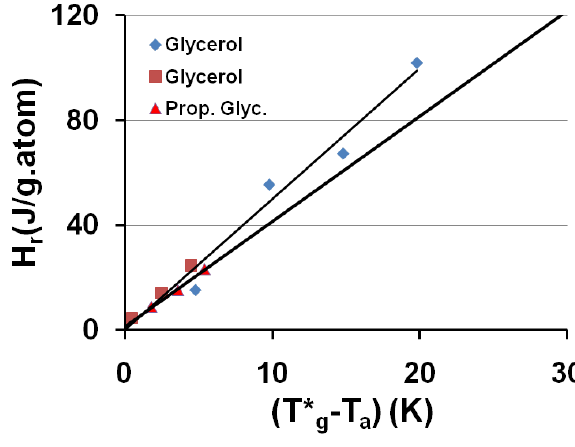
Figure 3. The saturated value of the relaxed enthalpy H is plotted versus (T* − T ), T* r g a g being the thermodynamic vitreous transition and T the annealing temperature; for N° 20 a glycerol, T* = 189.8 K and the slope of the straight line  C = 4.99 J/g.atom and for N° 2 g pgl propylene glycol T* = 171 K and  C = 4.02 J/g.atom. The corresponding values of T g pgl 0g calculated from T* are 121 and 112 K respectively. The largest values of H are due g r to [68] and the smallest ones to